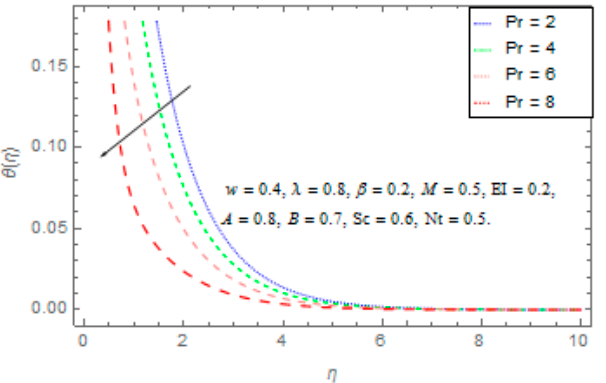
Figure 7. Influence of Rd on temperature profile.